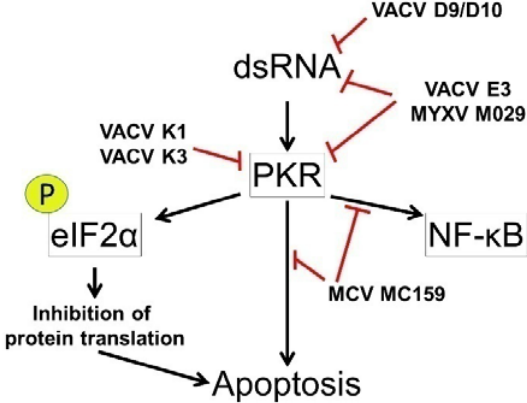
Figure 2. Viral double stranded RNA (dsRNA) activates protein kinase R (PKR). Upon binding dsRNA, PKR becomes activated and elicits several antiviral responses. Active PKR phosphorylates eukaryotic initiation factor 2 α (eIF2 α ) resulting in inhibition of protein translation. PKR can also mediate apoptosis and NF- κ B activation. Several poxvirus proteins inhibit PKR activation using a variety of mechanisms. The red lines indicate points in the pathway targeted by several poxvirus immune evasion molecules.